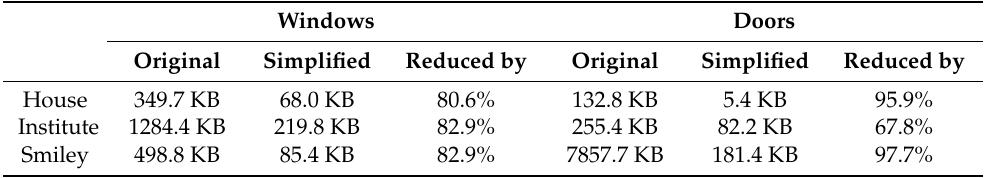
Table 9. File size of windows and doors before and after simplification.